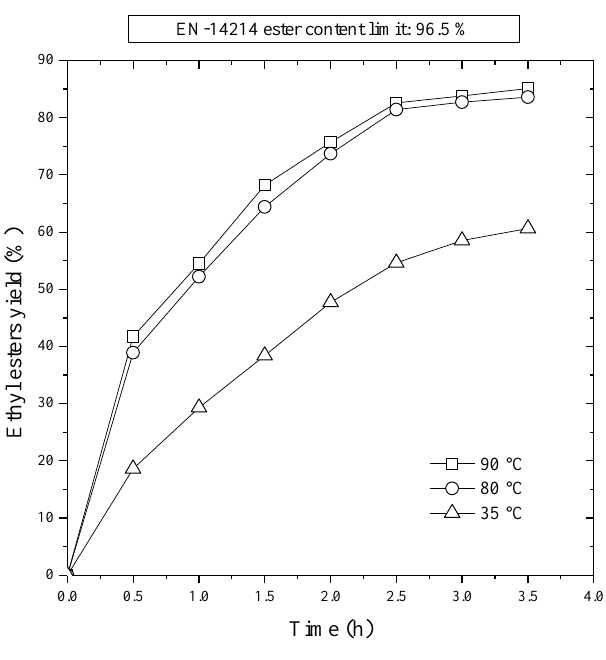
Figure 2. First stage transesterification. Effect of reaction temperature on ethyl ester